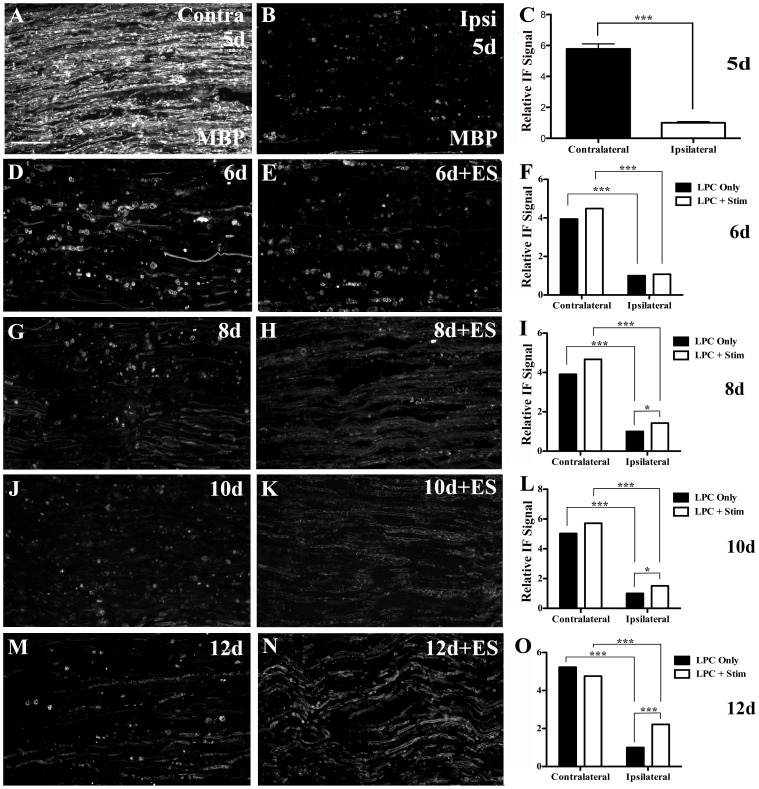
Increased myelin basic protein (MBP) expression following 1hr ES delivered 5 d post-LPC.Representative photomicrographs from FG-positive areas on longitudinal sciatic nerve sections processed for MBP immunofluorescence (IF) reveal extensive demyelination 5d post lysophosphatidyl choline (LPC)/FG demyelinating injection (B) as compared to contralateral normal control nerves (A). Temporal analysis of LPC) focal demyelination +/- electrical stimulation (ES) as indicated in days post-LPC: 6d (D), 6d+ES (E), 8d (G), 8d+ES (H), 10d (J) 10d+ES (K) and 12d (M) 12d+ES (N) post-LPC. Note: In the LPC only group, MBP IF was localized in distinct patches consistent with uptake by phagocytosing cells (D, G, J) with faint linear regions similar to periaxonal MBP localization observed by 12 days post-LPC only injection (M). In contrast, in the LPC + ES group faint regions of MBP peri-axonal-like IF were already apparent 8d post-LPC (3d post-ES; H) and consistently stronger in the 10d post-LPC (5d post-ES; K) and 12d post-LPC (7d post-ES; N). Summary bar graphs of relative changes in immunofluorescence signal for MBP in regions of demyelination (C, F, I, L, O). Note: values obtained from individual slides at each time point were normalized to the mean value of the Average Gray per micron2 readings for the nerves ipsilateral to LPC treatment for the LPC only animal on that slide and for that time point. N = 4-6 animals analyzed per condition; regions quantified per condition: 49 ipsi and 38 contra (5d, LPC only); 128 ipsi and 76 contra (6d, LPC only); 81 ipsi and 54 contra (6d LPC+Stim); 83 ipsi and 49 contra (8d, LPC only); 60 ipsi and 58 contra (8d, LPC+Stim); 62 ipsi and 52 contra (10d, LPC only); 54 ipsi and 48 contra (10d, LPC+Stim); 155 ipsi and 73 contra (12d, LPC only); 119 ipsi and 104 contra (12d LPC+Stim). Asterisks indicate significant differences between experimental groups; *P<0.05, **P<0.01, ***P<0.001. Scale bar  =  100 µm.